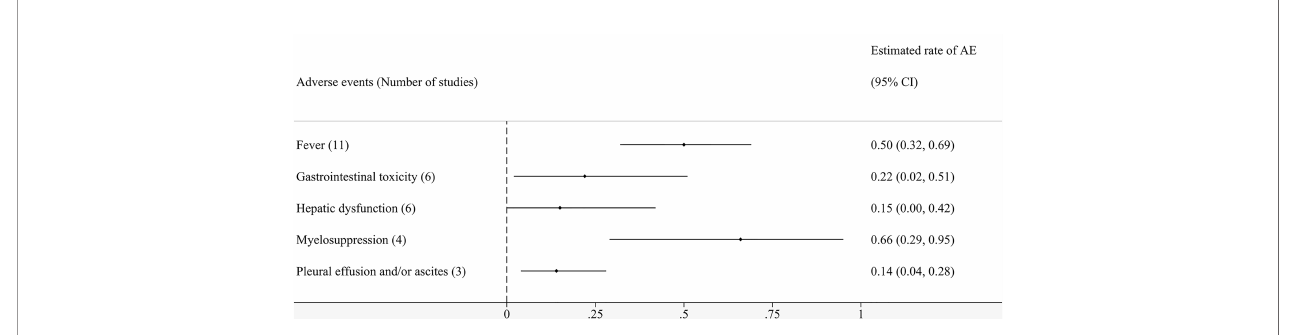
FIGURE 6 | Pooled analyses on incidence of various adverse events.